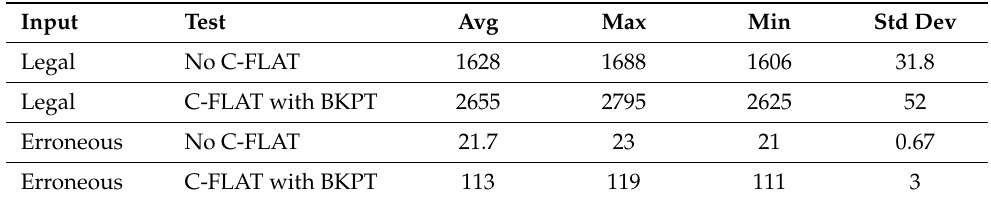
Table 4. AdvanceCOMP 2.1